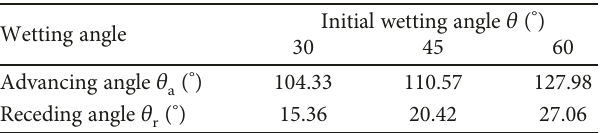
Figure 6: The deformation curve of residual oil with initial wetting angle. Table 2: Advancing and receding contact angle (initial wetting angle).